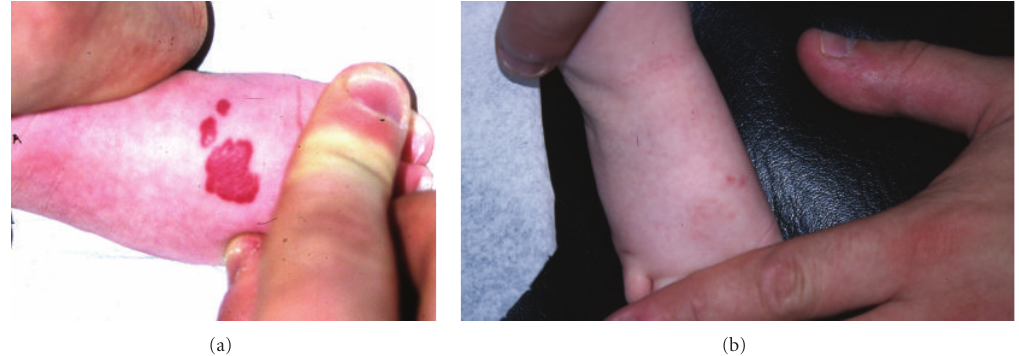
Figure 4: Infant 1 with haemangioma of the foot before and after 4 treatments with Photoderm.